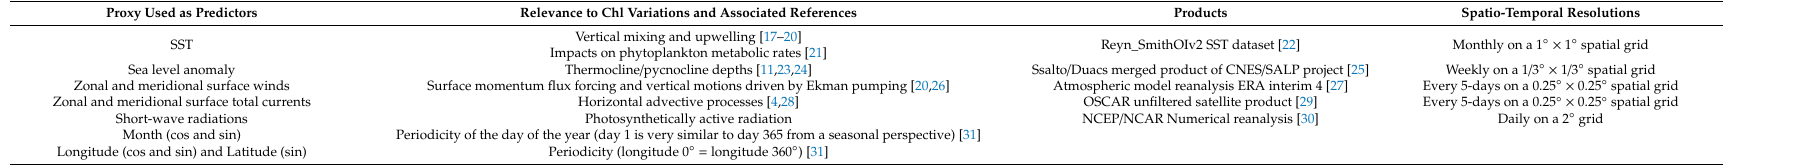
Table 1. Physical predictors, their relevance to Chl variability, the products used, and their